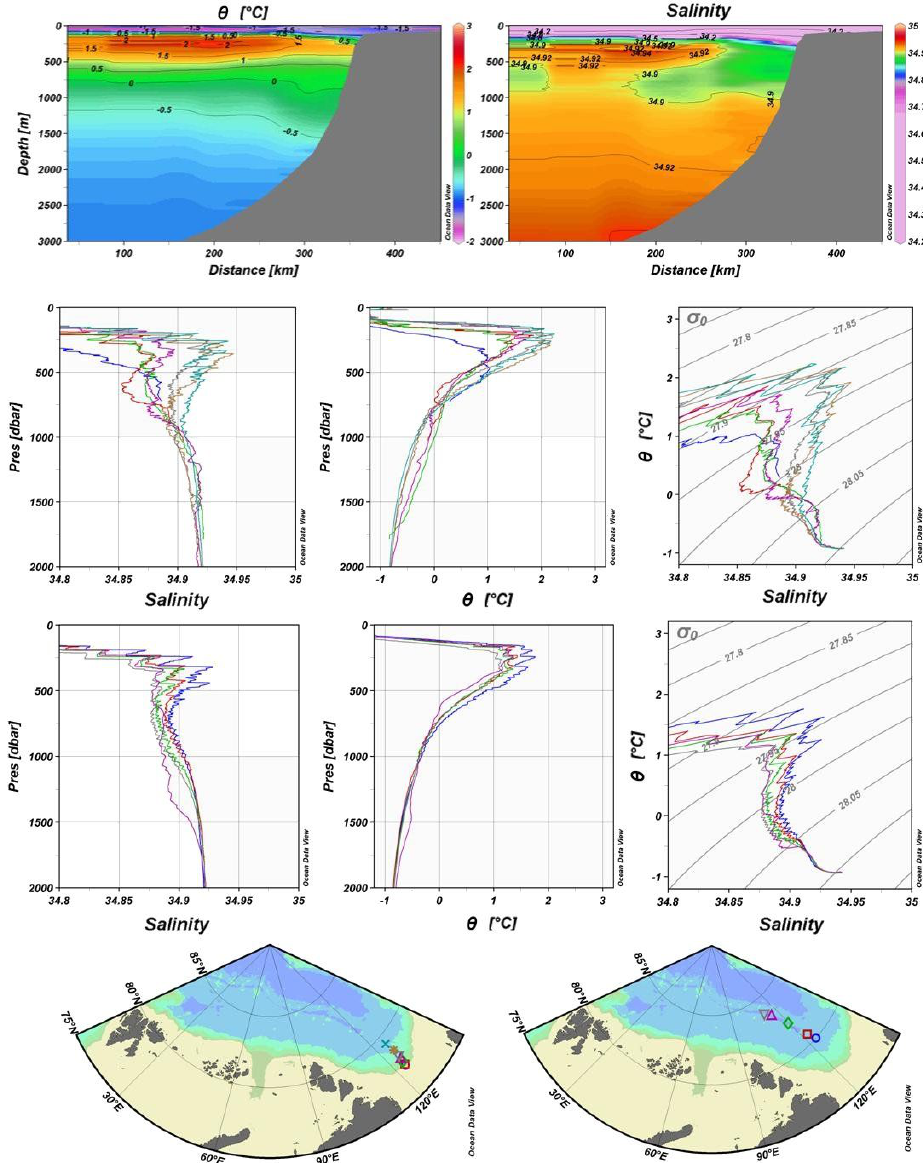
Fig. 13. Water masses mixing and interleaving along the Gakkel Ridge north of the Laptev Sea. Upper panel: temperature and salinity sections from the shelf along the Gakkel Ridge showing a colder and less saline Fram Strait Atlantic core compared to the Kara Sea section (Fig. 12) and the Barents Sea branch water has spread from the slope into the basin. It is also observed on the basin side of the warm core. Upper centre panel: potential temperature and salinity profiles and θS curves from the slope showing interleaving between the two branches. Note that no smooth warm and saline Atlantic core is present. Interleaving layers are found everywhere. Lower centre panel: potential temperature and salinity profiles and θS curves along the Gakkel Ridge showing the interleaving structures. Lower panel: maps showing the positions of the stations. Data from Polarstern